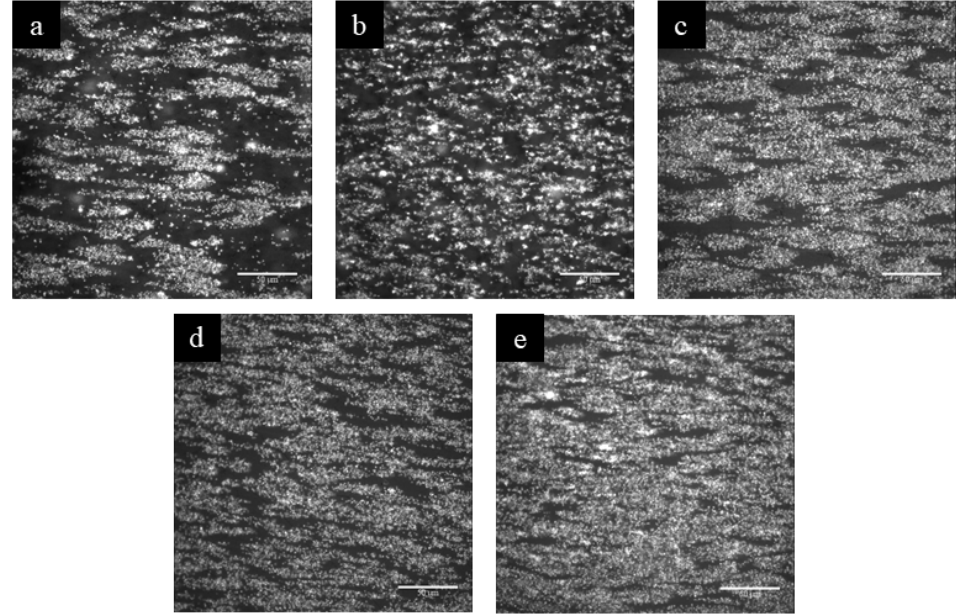
Figure 4. Fluorescence micrographs of DIOC6 labelled whole blood platelets in frame 120/120 for each of 5 replicates ( a – e ) of the air-spun-coated 25PS75PMMA_750 surface (Scale bar = 50 µm). Platelet adhesion appears to be significantly higher for this surface, with platelets covering a large proportion of the field of view. Surface coverage values are again shown in Table 4 and indicate an average (n = 5) of 40.20 ± 13.30% surface coverage within the field of view. Within the regions covered by platelets, there are significantly ‘brighter’, more densely fluorescent areas that indicate the formation of 3D thrombi building within the microfluidic channel. Table 4. Average % surface coverage values (n = 5) ± standard deviation (SD) taken from frame 120/120 of fluorescently-labelled platelets on 25PS75PMMA and 25PS75PMMA_750 substrates after DPFA testing.